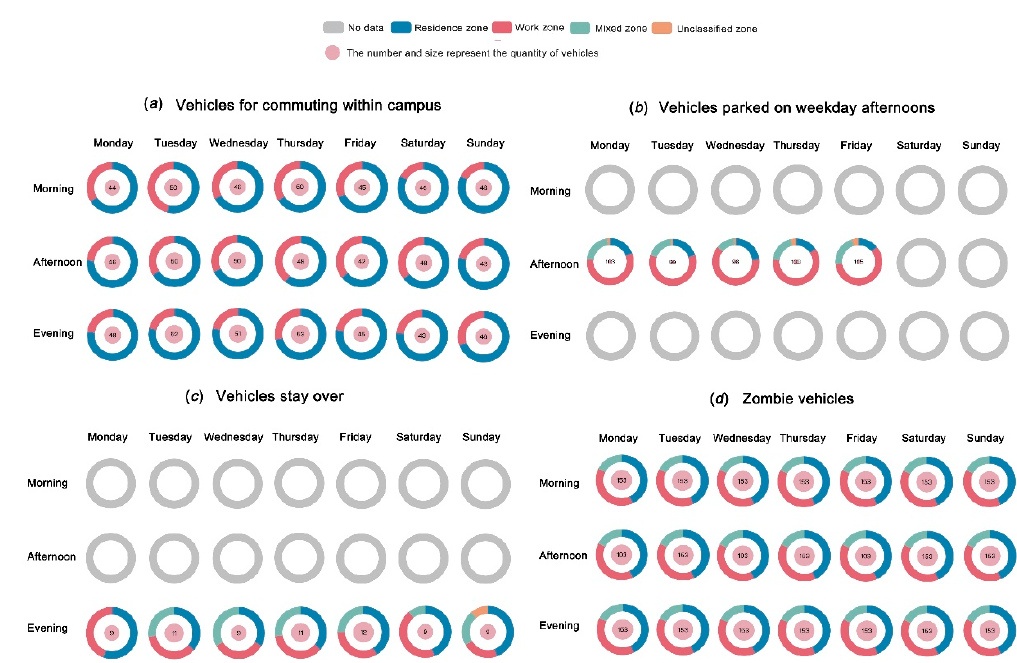
Figure 10. Parking calendars of vehicles with certain semantic patterns. ( a ) Vehicles for commuting within campus; ( b ) vehicles parked on weekday afternoons; ( c ) vehicles staying over; ( d ) zombie vehicles. The outer donuts represent the proportion of vehicles that belong to a specific pattern (e.g., zombie vehicles) parking in each of the four parking zones. The four colors in the outer donuts refer to the four parking zones. The number and size of inner circles imply the quantity of vehicles of a specific pattern appearing in the specific period. For example, there are 447 vehicles belonging to the category “vehicles parked on weekday afternoons”, but only 103 of them appear in the Monday afternoon time period.